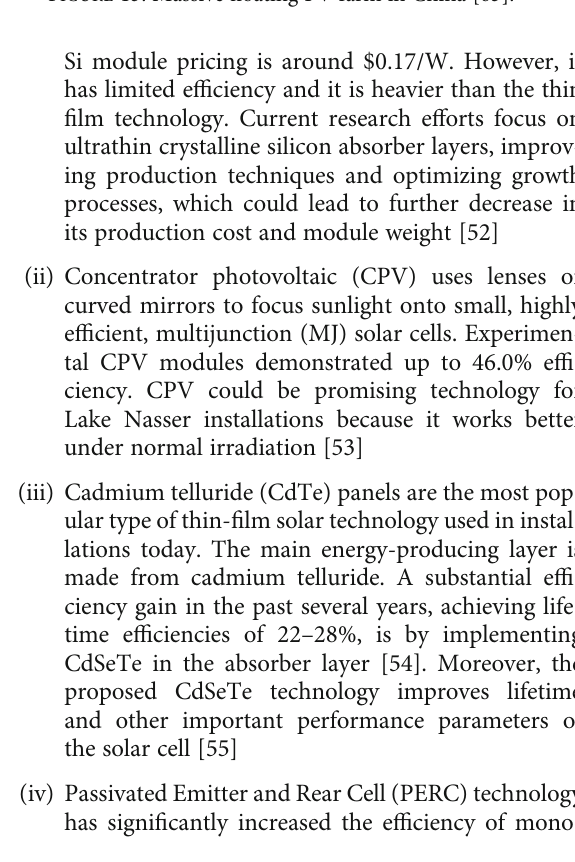
Figure 15: Massive fl oating PV farm in China